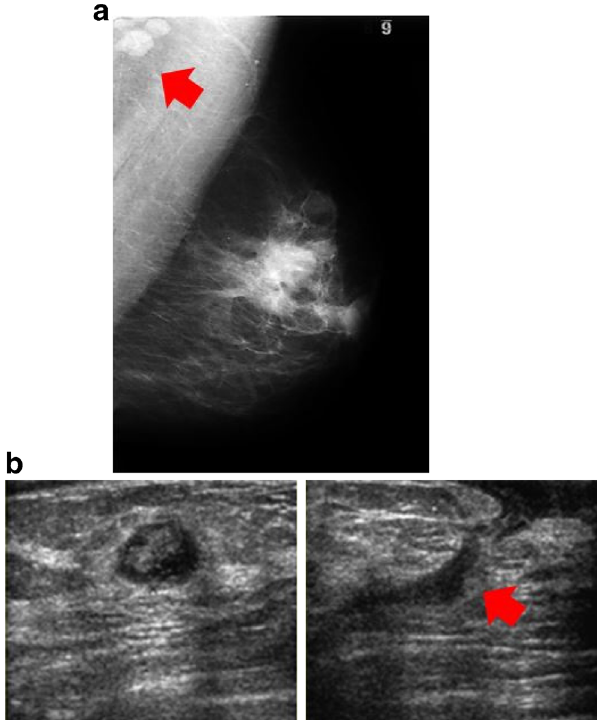
Fig. 3 Infectious cause: Mycobacterium fortuitum . A 32-year-old wom- an had a new tender, palpable mass in the left breast. Biopsy showed granulomas, and purulent drainage from the needle tract was positive for M. fortuitum . Treatment with antibiotics, based on the sensitivity of the organism, led to resolution of the infection. a Left mediolateral- oblique view showed multiple masses with prominent left axillary lymph nodes ( red arrow ) and periareolar skin thickening. b Ultrasound showeda complex, hypoechoic fluid collection ( left ) with sinus tract extending to skin ( red arrow ) ( right